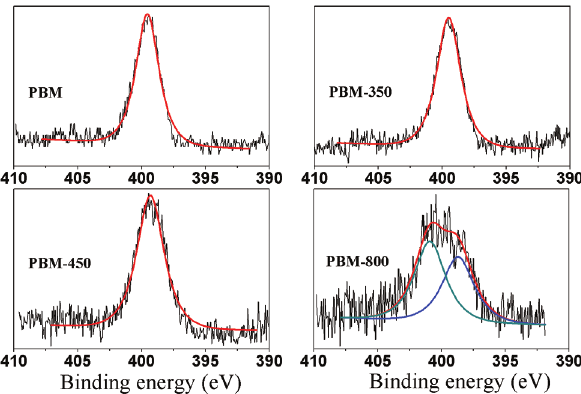
Fig. 3: N 1s XPS spectra of PBM and its chars obtained at various